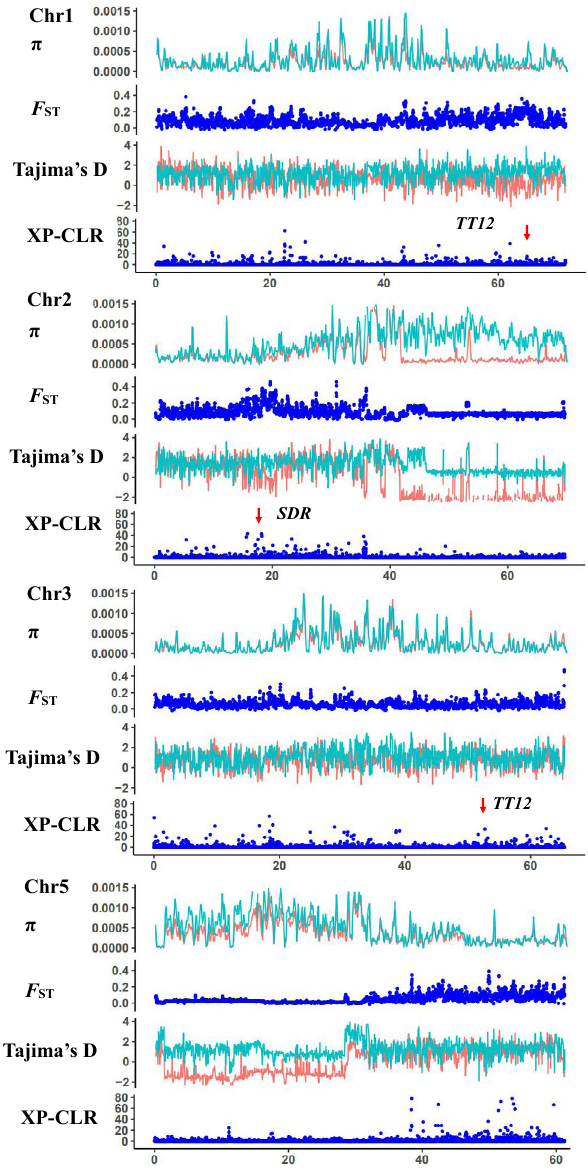
Fig. 6 Signatures of selected signals in chromosomes 1, 2, 3, and 5 of M. integrifolia genome. The upmost dotplot is nucleotide diversity ( π ) values, red indicate varieties and green line indicate wild group; the second lay is fi xation index ( F ST ) between the wild and cultivated macadamia accessions; the third lay is Tajima ’ s D values, red indicate varieties and green line indicate a wild group. The bottom is the genome-wide distribution of selective-sweep signals identi fi ed based on the cross- population composite likelihood ratio test (XP-CLR). TT12 , TRANSPARENT TESTA; SDR short-chain dehydrogenase reductase, ANS anthocyanidin